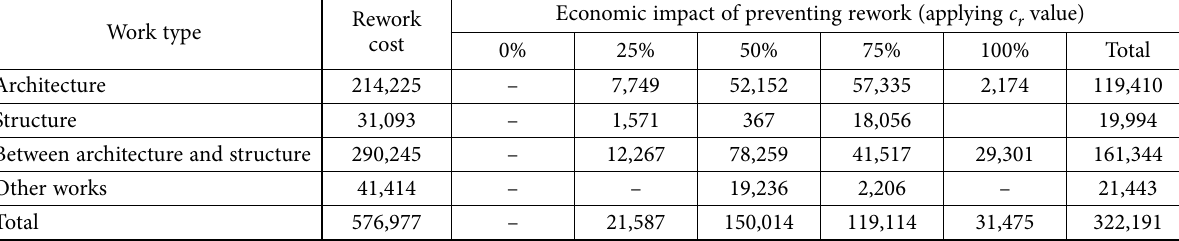
Table 7. Results of economic impact of preventing rework (in